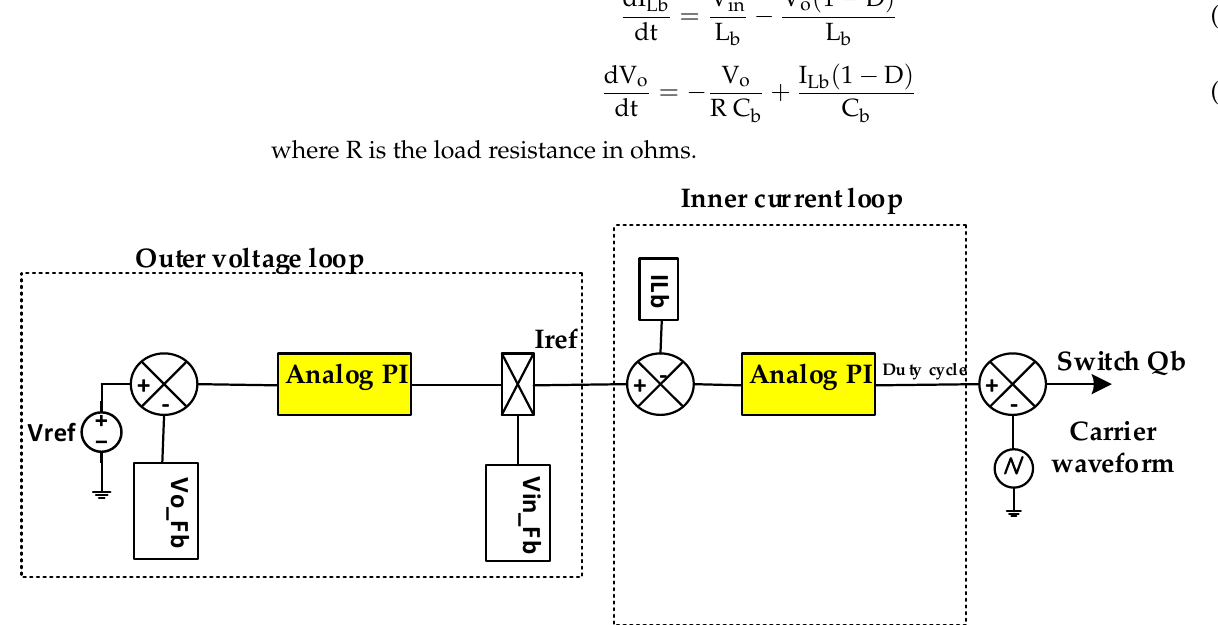
Figure 8. Implementation technique of the conventional CCM PFC analog control circuit.